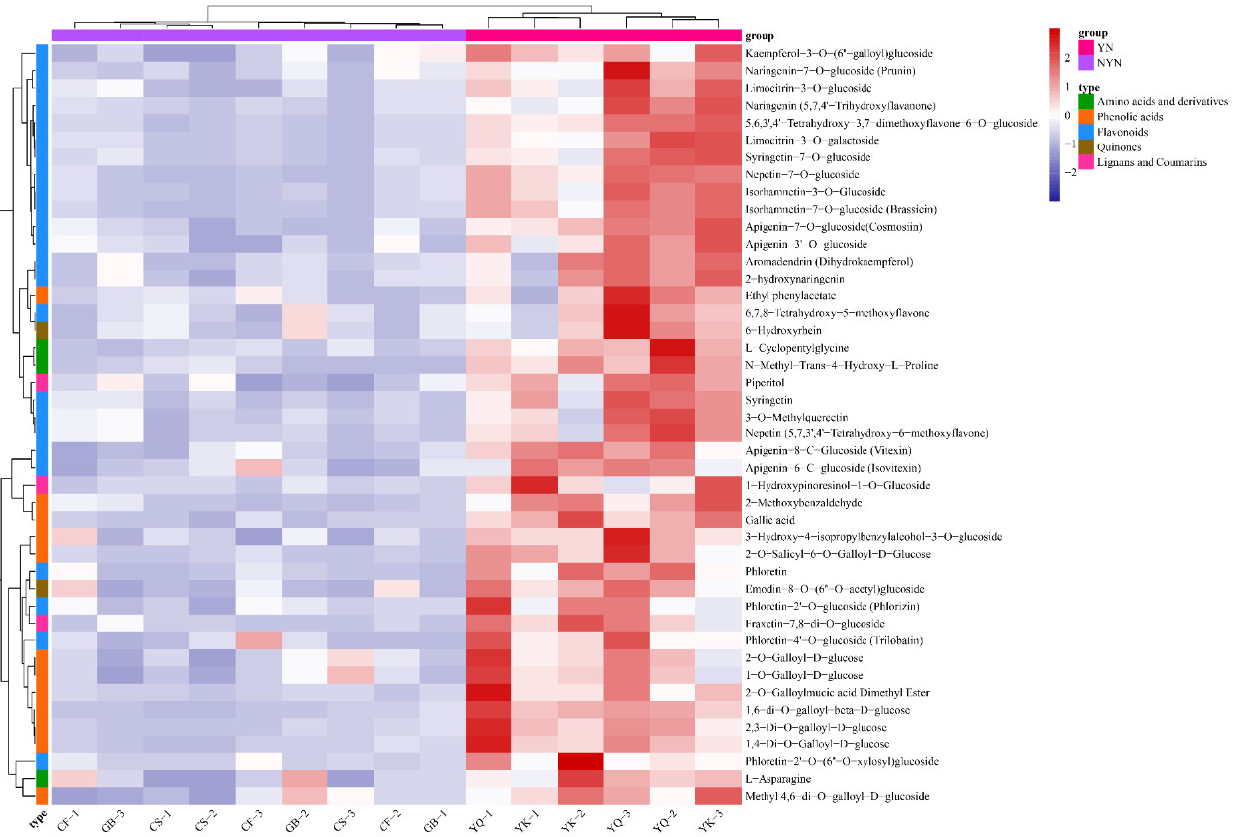
Figure 8. Heatmap of differential metabolites from FDR samples of NYN group and YN group. Red colors show high abundance, whereas low abundance is presented by blue.